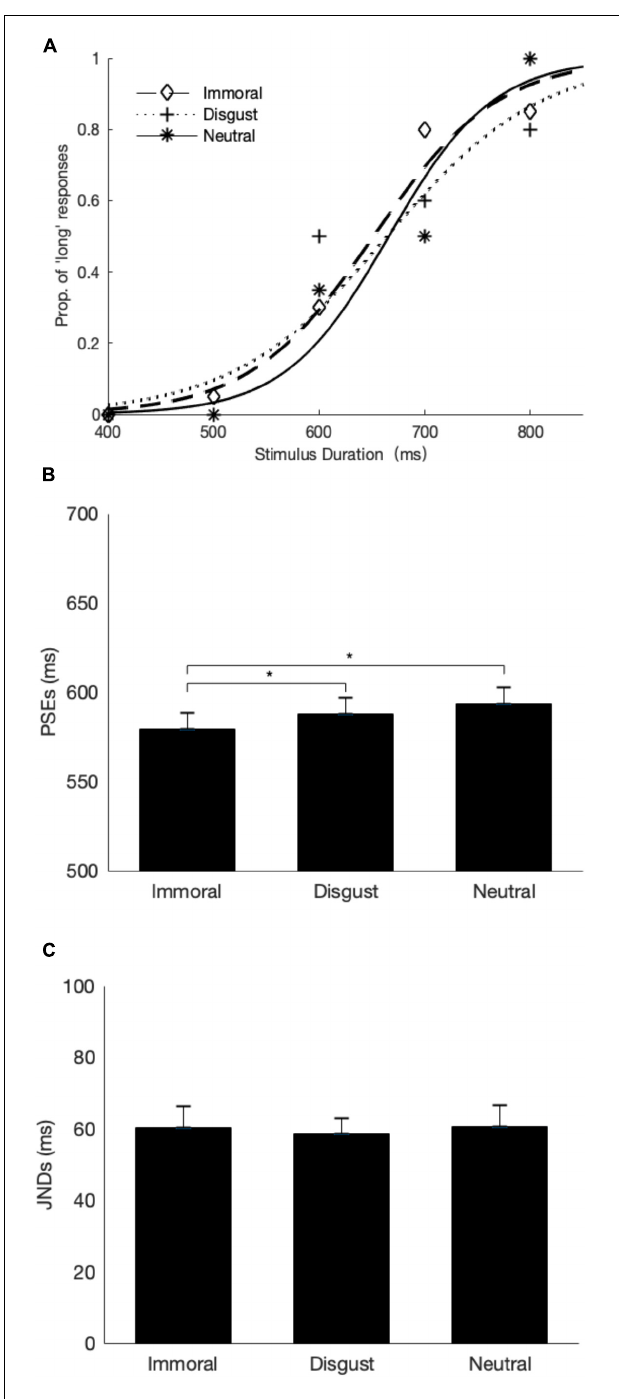
FIGURE 4 | Temporal bisection results of Experiment 2. (A) The mean proportions of “long” responses from a representative subject are plotted (diamonds: the immoral phrase; crosses: the disgust phrase; and stars: the neutral phrase) against the probe durations, together with the fitted psychometric curves (dashed: the immoral phrase, dotted: the disgust phrase, and solid: the neutral phrase). (B) The mean PSEs and their respective one-standard errors are shown for the three conditions. (C) The mean JNDs and their respective one-standard errors are displayed for the three conditions. * denotes p ≤